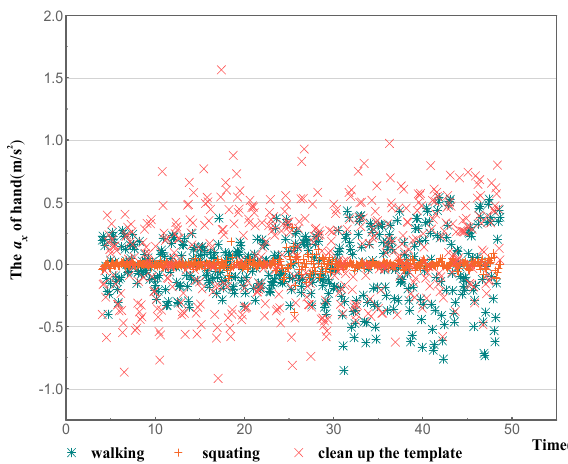
Figure 8. Scatter plot of a x for walking, squatting, and cleaning up the template.